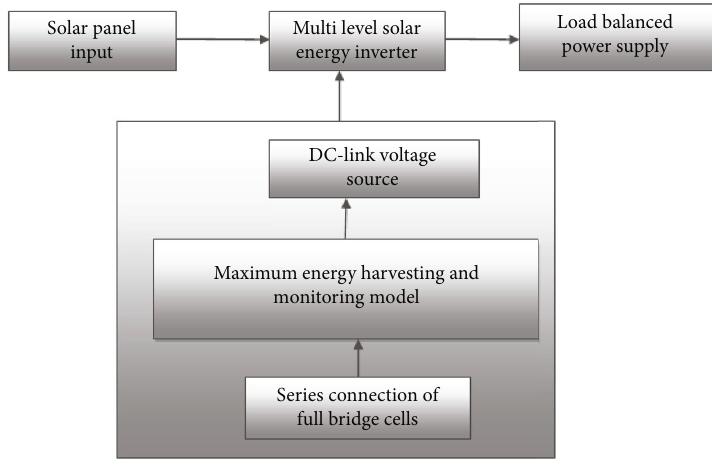
Figure 4: Proposed maximum energy harvesting and